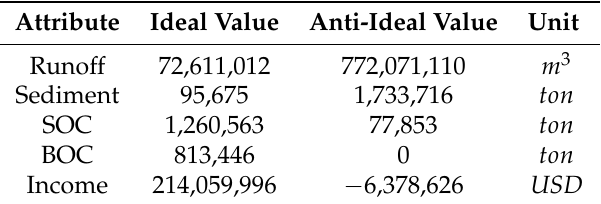
Table 5. Ideal and anti-ideal points for the Tabacay database. Values are aggregated over a 30 years period.